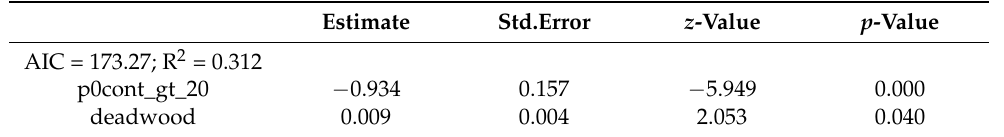
Table 2. Final model to explain the occurrence of Buxbaumia viridis across Austrian; AIC = Akaike information criterion; for abbreviations of climate variables see Table